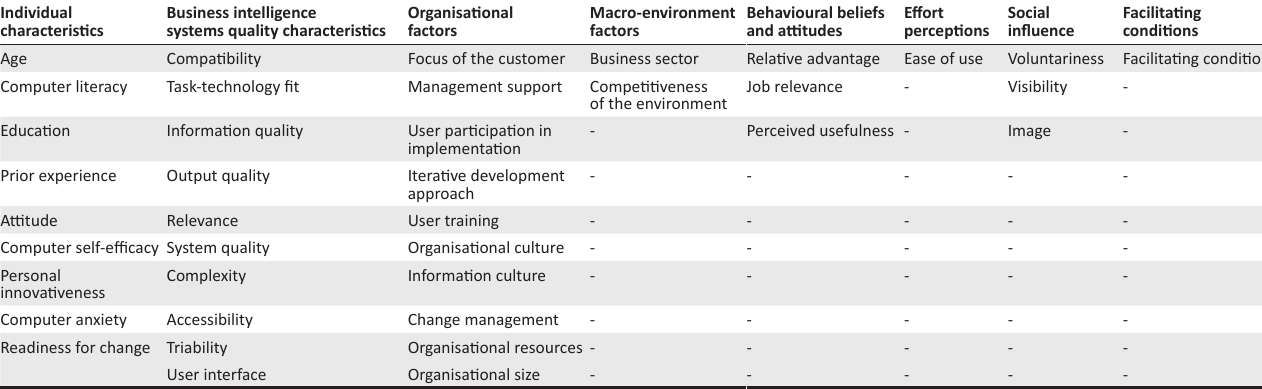
TABLE 1: Determinants influencing dimensions of business intelligence